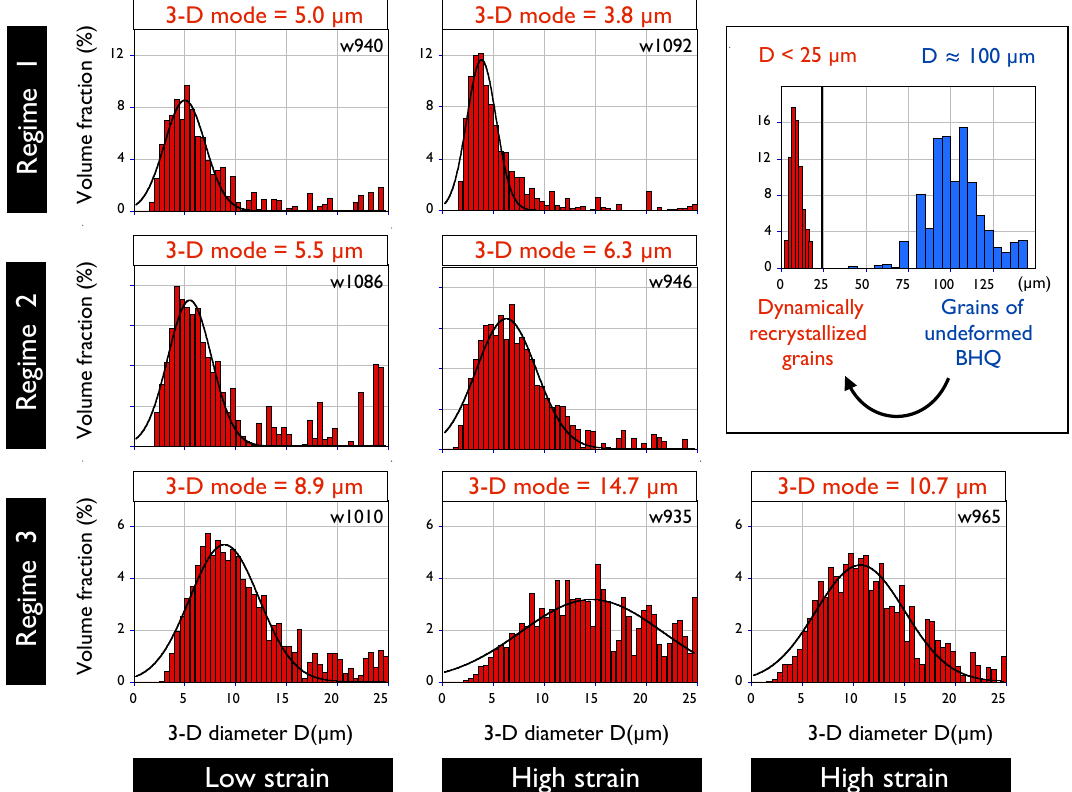
Figure 4. Recrystallized grain size for dislocation creep regimes 1, 2, and 3. Volume-weighted histograms v(D) are shown for seven samples for relatively low (2 . 7 < γ < 4 . 3) and high shear strains (5 . 8 < γ < 7 . 1). D is the diameter of volume equivalent sphere. The mode of v(D) is obtained by a Gaussian normal fit to the distribution. Inset shows the grain size distribution of undeformed and deformed Black Hills Quartzite for